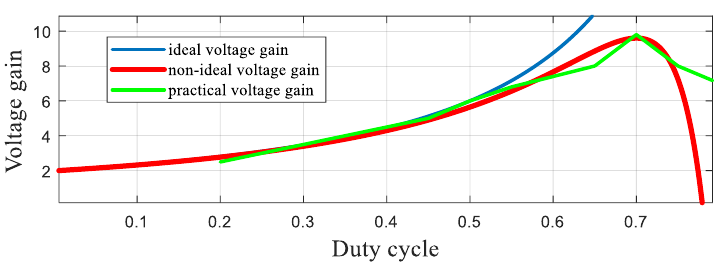
Figure 14. The comparison of the non-ideal voltage gain based on the extracted relations and practical voltage gain based on the experimental